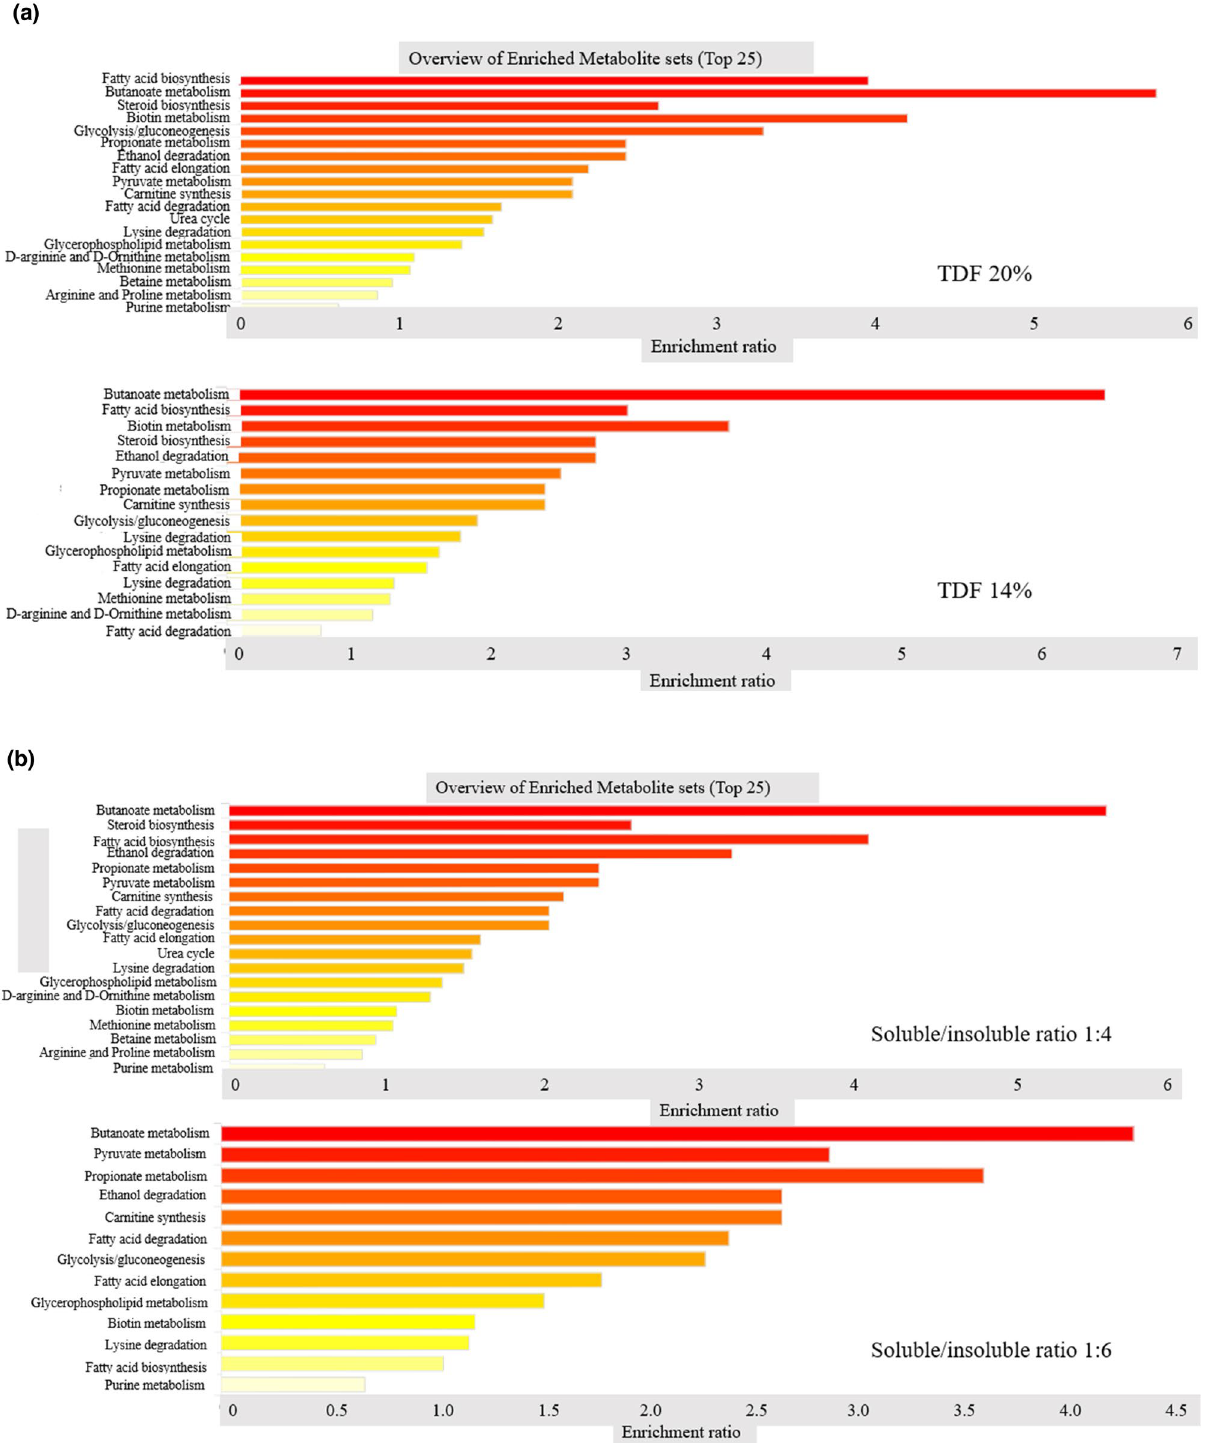
Figure 3. Effect of dietary fiber levels and soluble, insoluble dietary fiber ratio on significant metabolite sets accountable for class discrimination with variable importance projection (VIP) > 1 identified in the feces of sows fed different fiber levels during late gestation. ( a ) 20% vs. 14% ditary fiber level; ( b ) 1:4 vs. 1:6 soluble to insoluble fiber